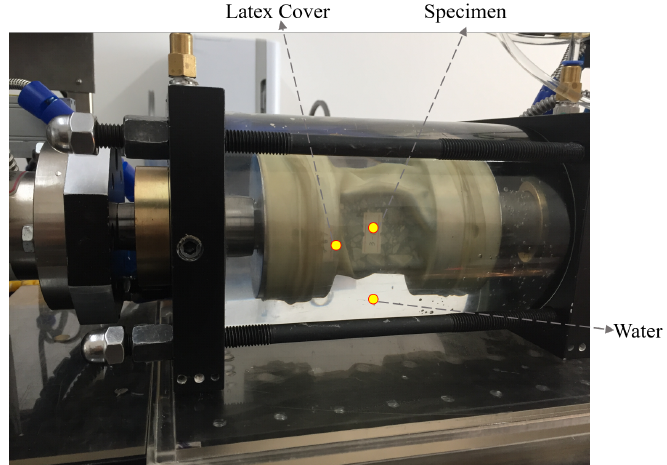
Figure 7. Experimental specimen.